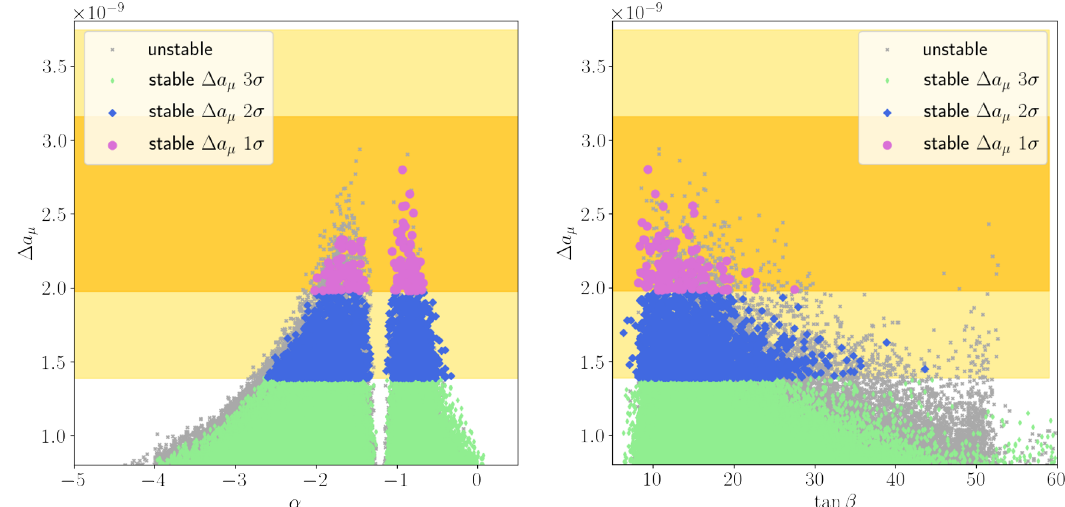
Figure 2 . Parameter points of α (left) and tan β (right) compatible with the muon g − 2 anomaly. The orange and yellow bands correspond respectively to the 1 σ and 2 σ ranges of the measured ∆ a µ value, and accordingly, the parameters points are colored in magenta ( 1 σ ), blue ( 2 σ ), and green ( 3 σ ). Points colored in gray violate the vacuum stability condition.